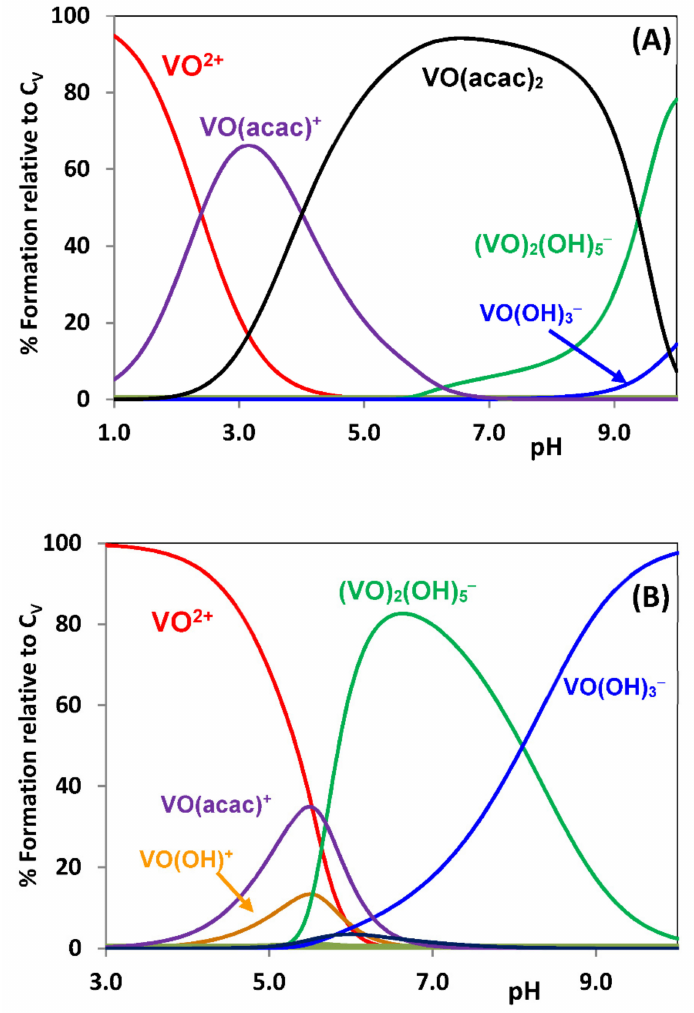
Figure 3. Species distribution diagrams, calculated with the computer program HySS [33], for total V IV O and acetylacetone concentrations of ( A ) 3 and 6 mM, respectively, and ( B ) 2 µ M and 4 µ M, respectively, considering the formation constants log β 110 = 8.73 and log β 120 = 16.27, reported in [46] and the V IV O-hydrolytic constants: [VO(OH)] + , [(VO) 2 (OH) 2 ] 2+ , [(VO) 2 (OH) 5 ] − and [VO(OH) 3 ] − in refs.